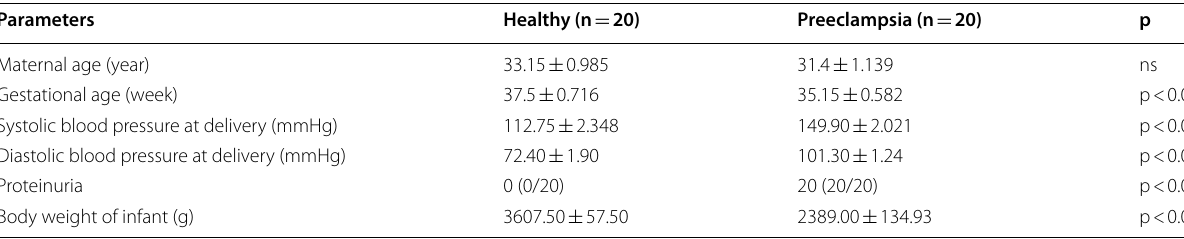
Table 1 Clinical characteristics of study population